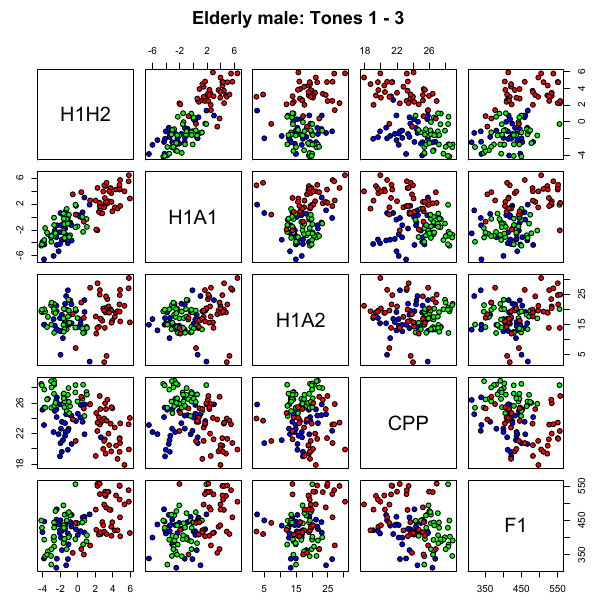
Figure 7 : Scatterplot matrices with five acoustic measures of breathiness for elderly males: blue for T1, green for T2, and red for